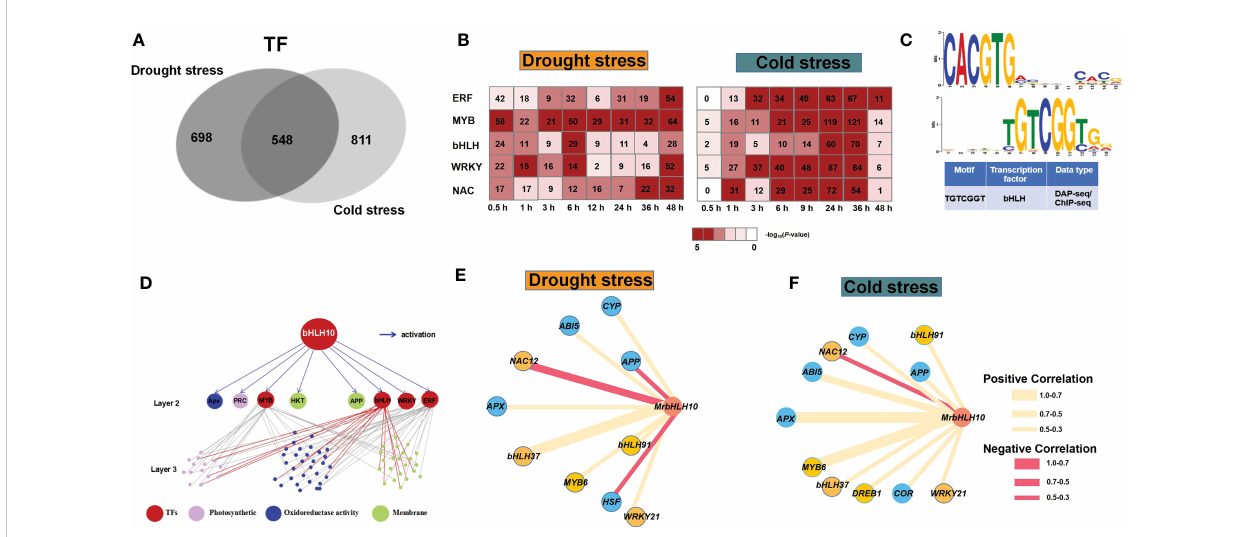
FIGURE 4 Gene regulatory networks of drought and cold-responsive transcriptional modulators. (A) Venn diagrams of TFs overlapping between drought stress and cold stress. (B) Enrichment ( – log10 (P-value)) of TF families in timepoint (0 – 48 h) under drought stress (left) and cold stress (right). The number represents the number of differentially expressed TF genes. The heatmap presents TF families enriched in at least one of 20 groups. (C) Bioinformatic analysis of bHLH Binding Site (TFBS) Motifs based on PlantTFDB database (http://planttfdb.gao-lab.org/). (D) Gene regulatory network of photosynthesis,